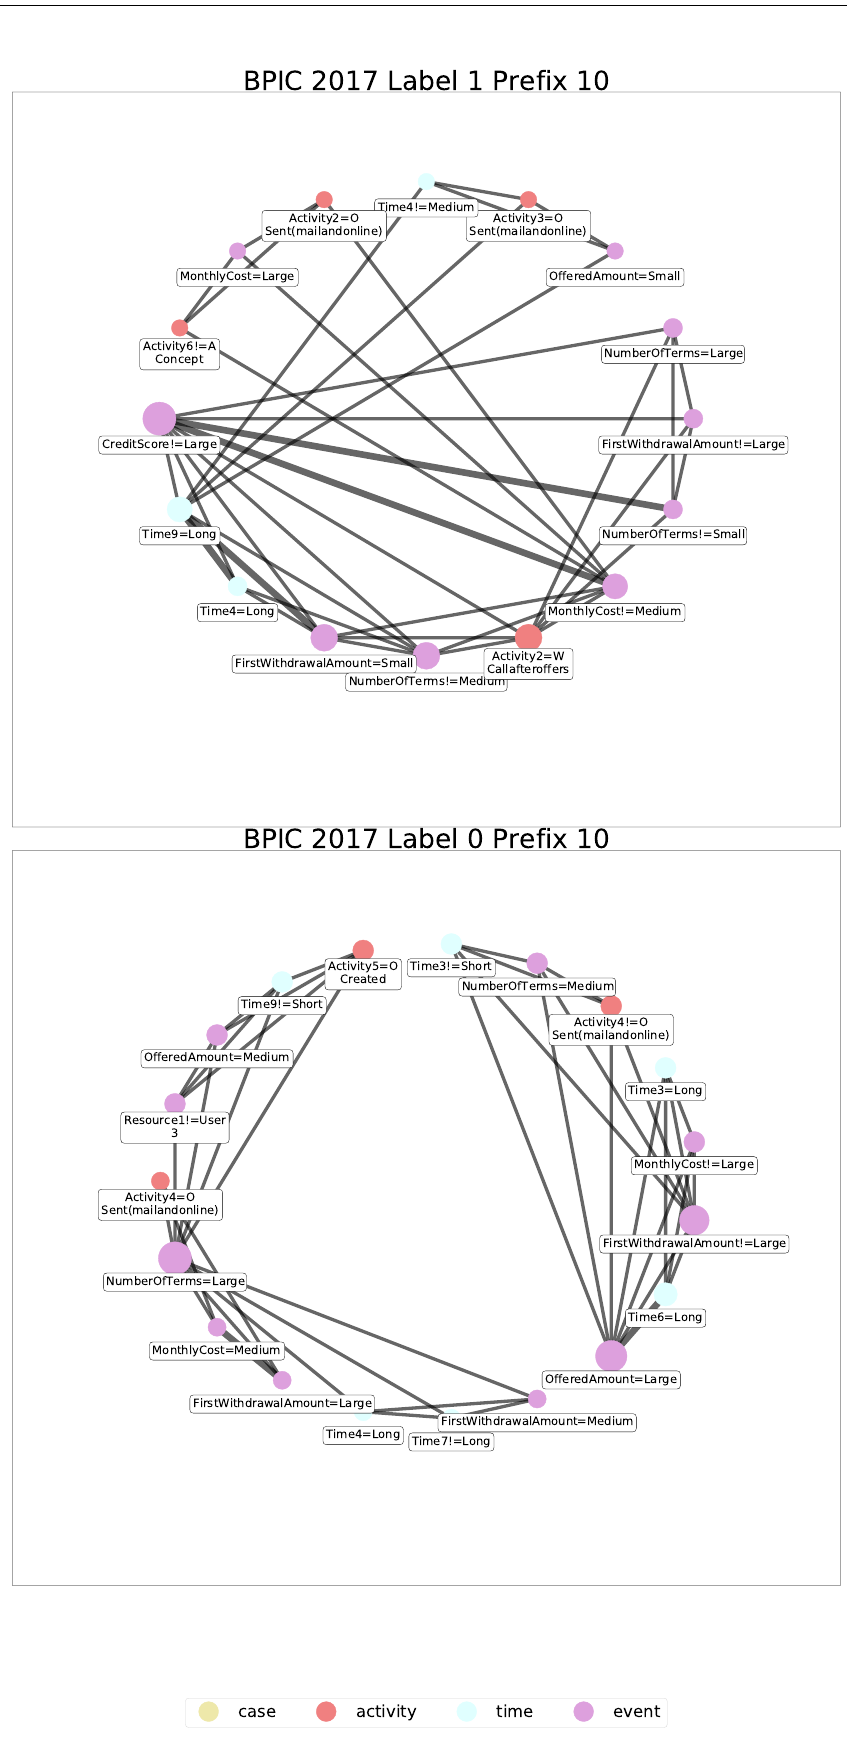
Figure 4. Example of global-level model visualisation (BPIC2017 event log at prefix